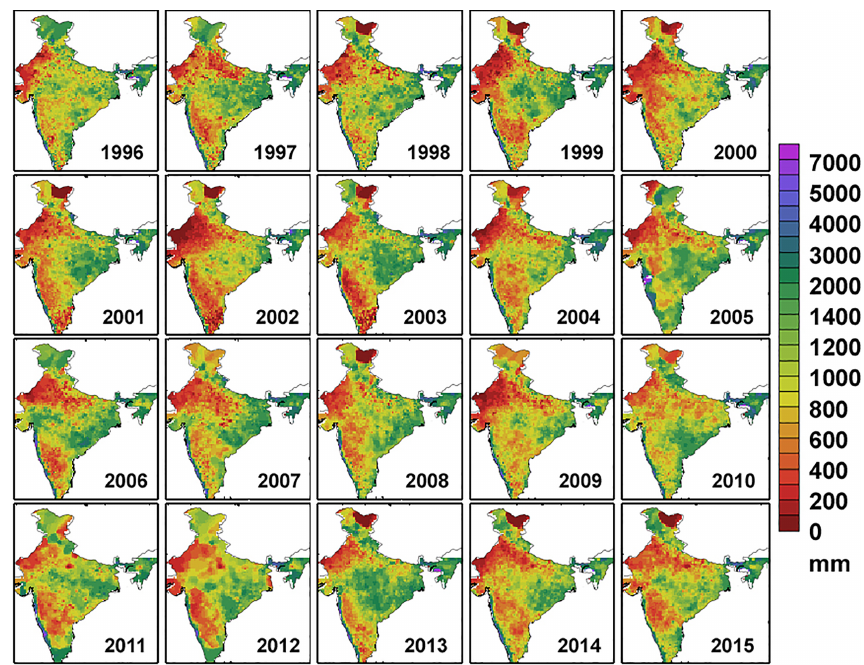
Figure 2. Maps showing total annual precipitation (mm) over the study area from 1996 to 2015.